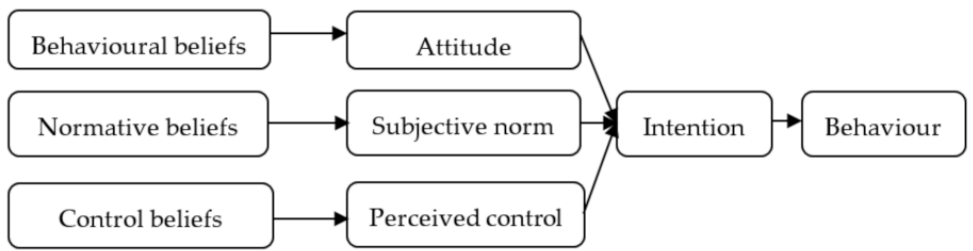
Figure 1. The default TPB conceptual framework.